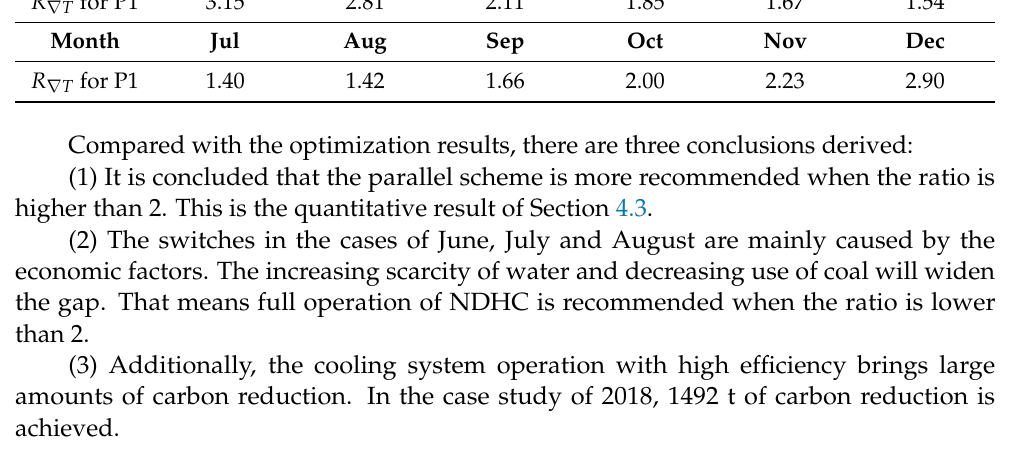
Table 10. The ratio of dry bulb temperature increase in dry section and wet section for the P1 scheme.